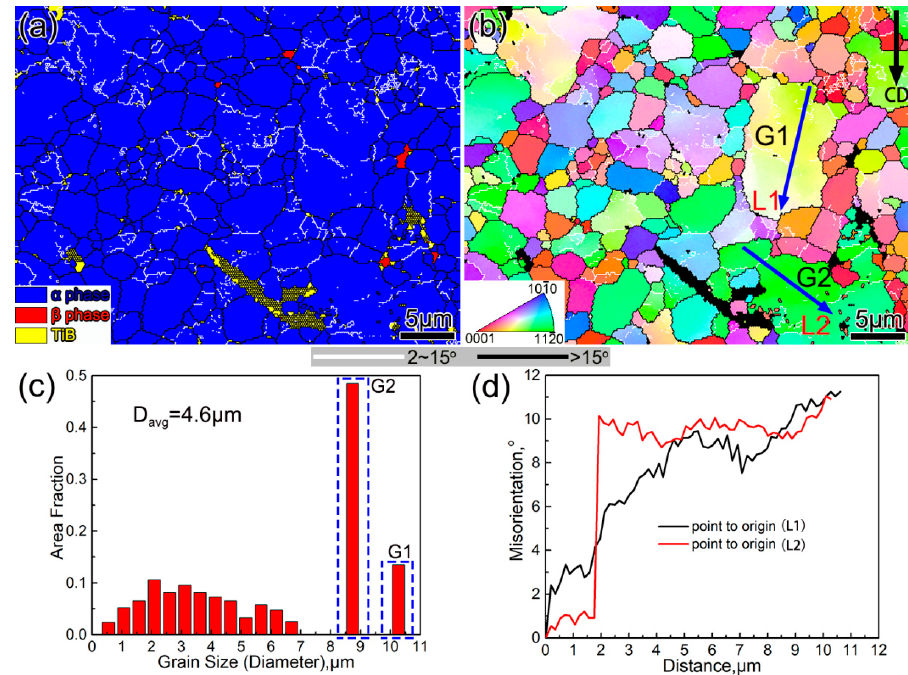
Figure 4. The electron backscatter diffraction (EBSD) analysis results of the as-forged composite: ( a ) the phase map; ( b ) the inverse pole figure map; ( c ) distribution of grain size; and ( d ) the misorientation profiles along the arrows L1 and L2, respectively.